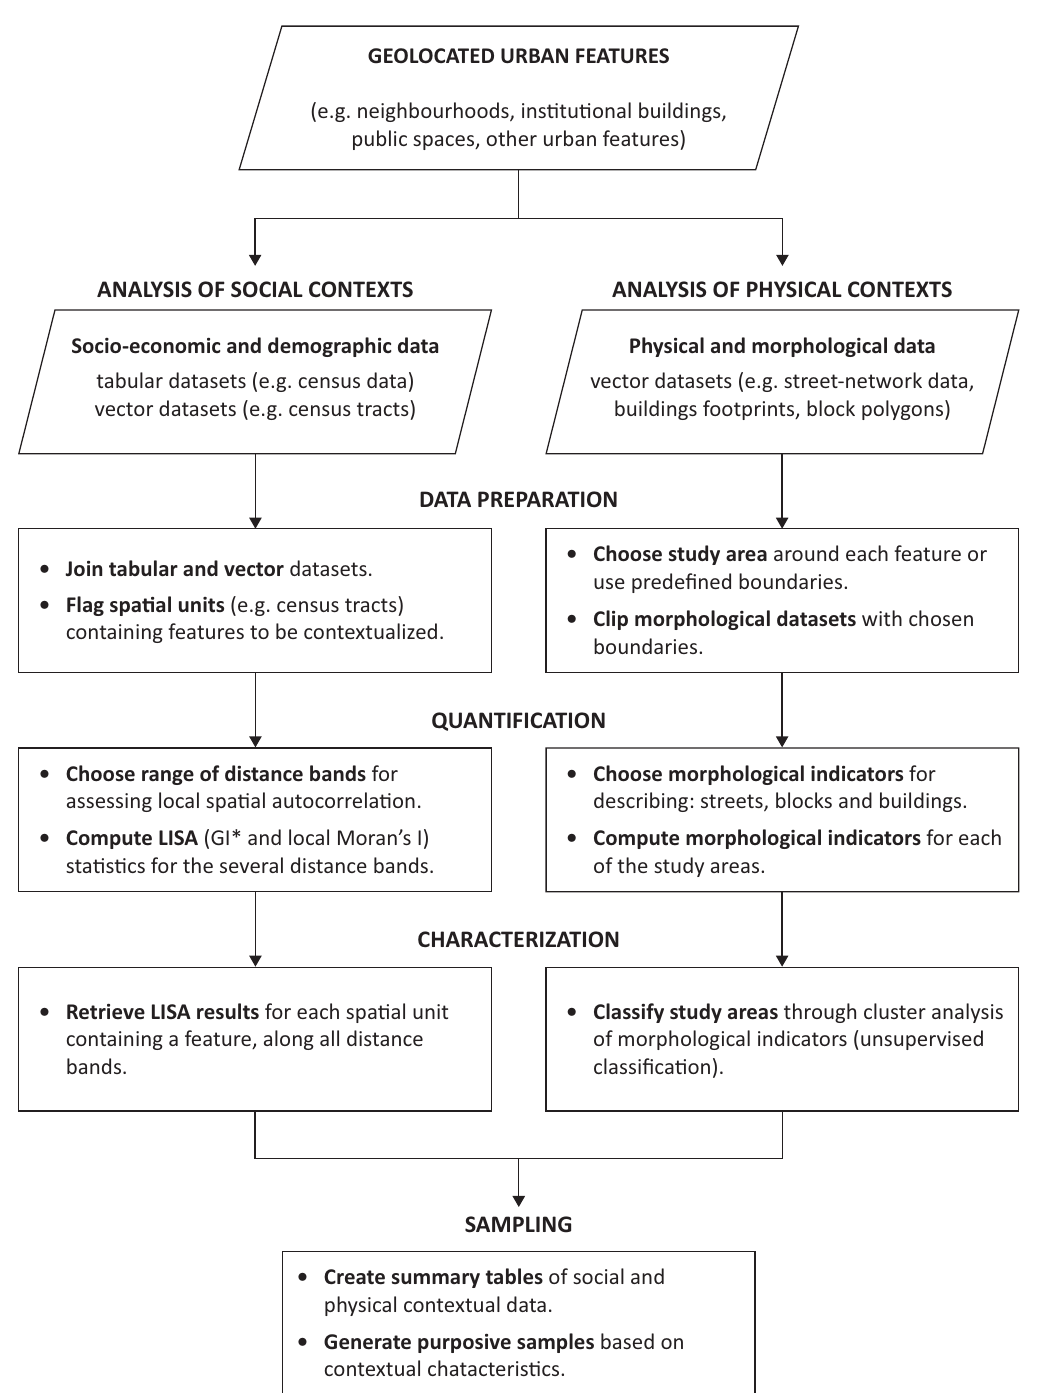
Figure 1. Proposed methodological framework, divided into two analysis tracks, each of which is organised into three stages and a synthesis in order to derive purposive